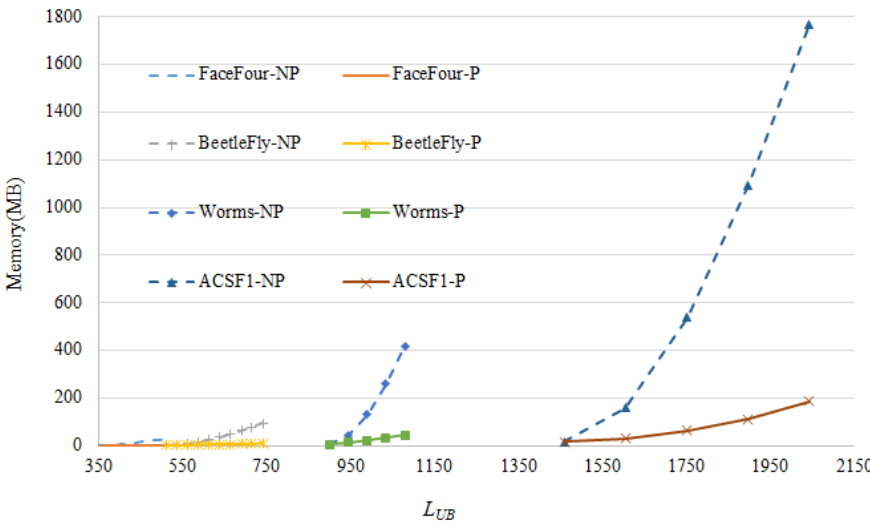
Figure 10. Comparisons between LDTW and our method in terms of time costs.